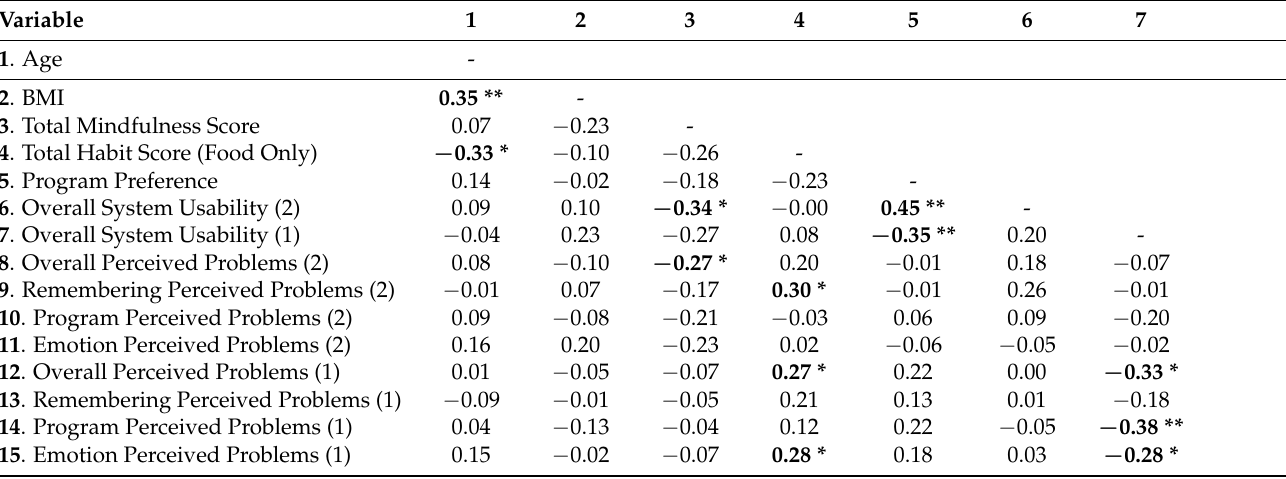
Table 3. Bivariate Correlation Coefficients to Determine Significant Relationships for all Target Variables ( N =